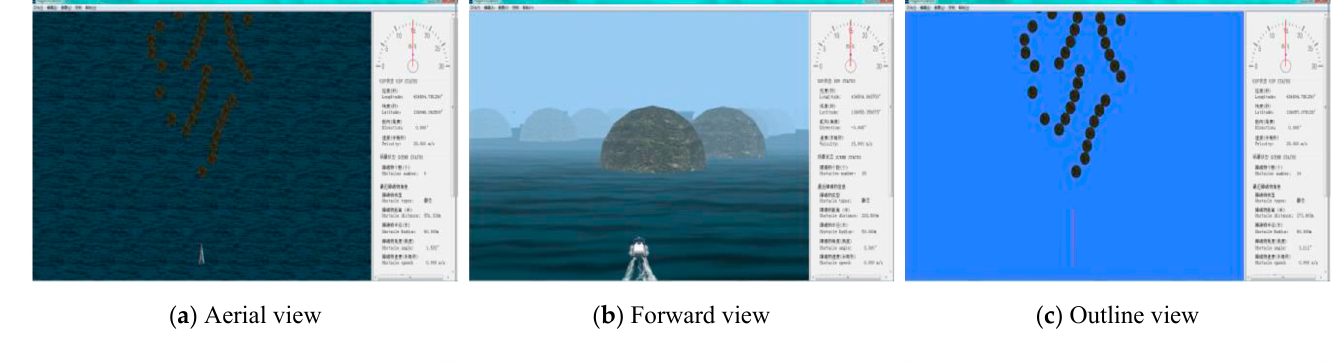
Figure 11. Interface of visual simulation.